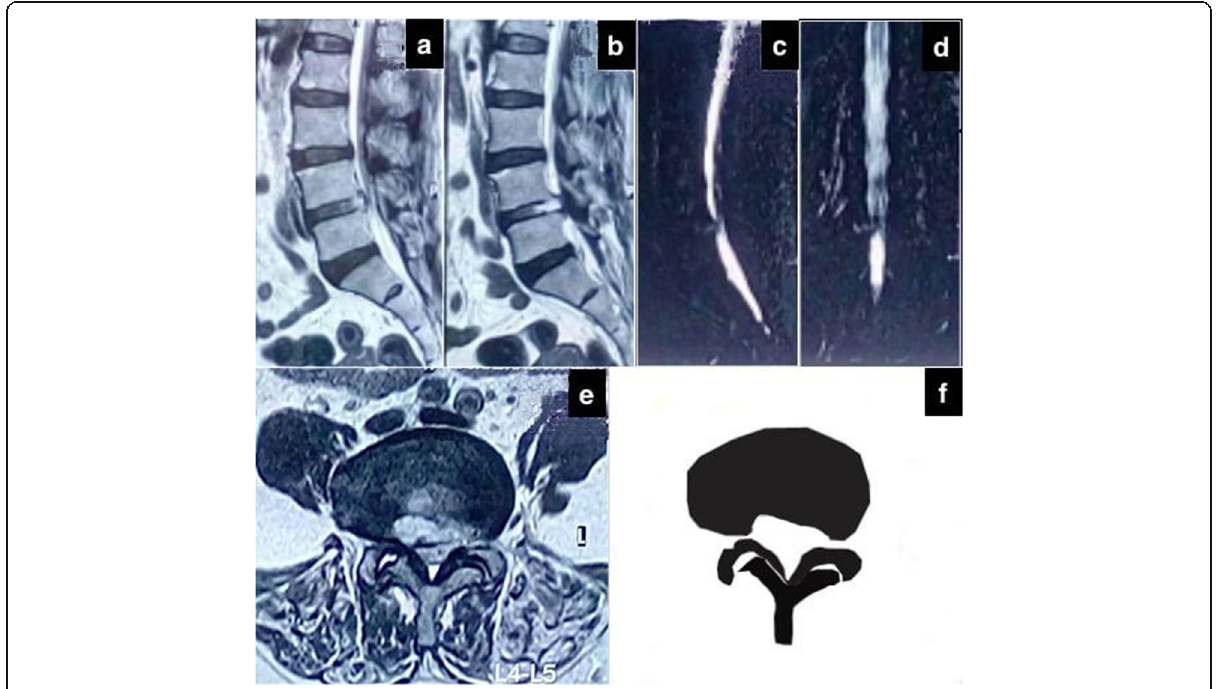
Fig. 3 Postoperative; a b T2 sagittal and para-sagittal MRI sections showing a decompressed disc prolapse (partial annulectomy and prolapsed targeted nucleus pulposus fragmentectomy). c , d MR myelogram showing myeloblock now opened up completely. e The T2 axial section showing ventral decompression starting from left side and extending to opposite right side ventral to opposite traversing root. f Illustrative image of figure e showing removal of optimal disc, dorsal facet, and ligament flavum (foraminoplasty) on left side as compared to opposite right